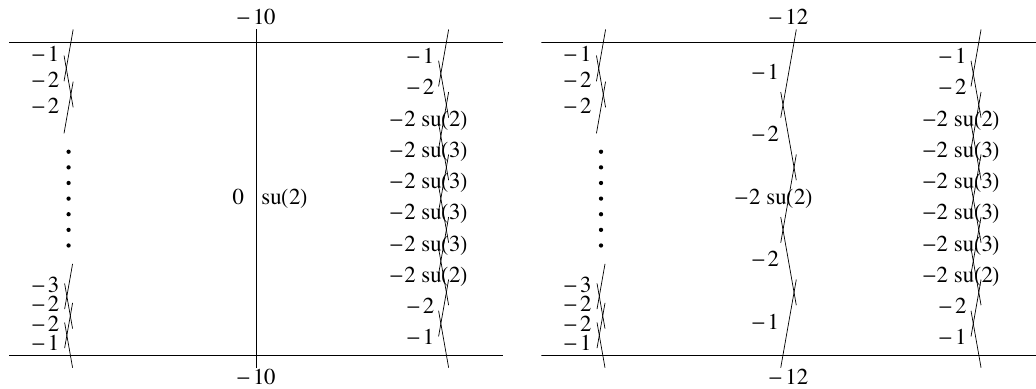
Figure 5 . Base resolution that gives rise to a tuned (cid:13)at elliptically (cid:12)bered CY. Left: before resolution. Right: after resolving (4,6) points in the base. The top curve is D 1 and the down curve is D 49 . The curves in the left chain from top to down are f D 2 ; D 2 ,. . . , D 48 g , in the right chain from bottom to top are f D 50 ; D 51 ; : : : ; D 59 g